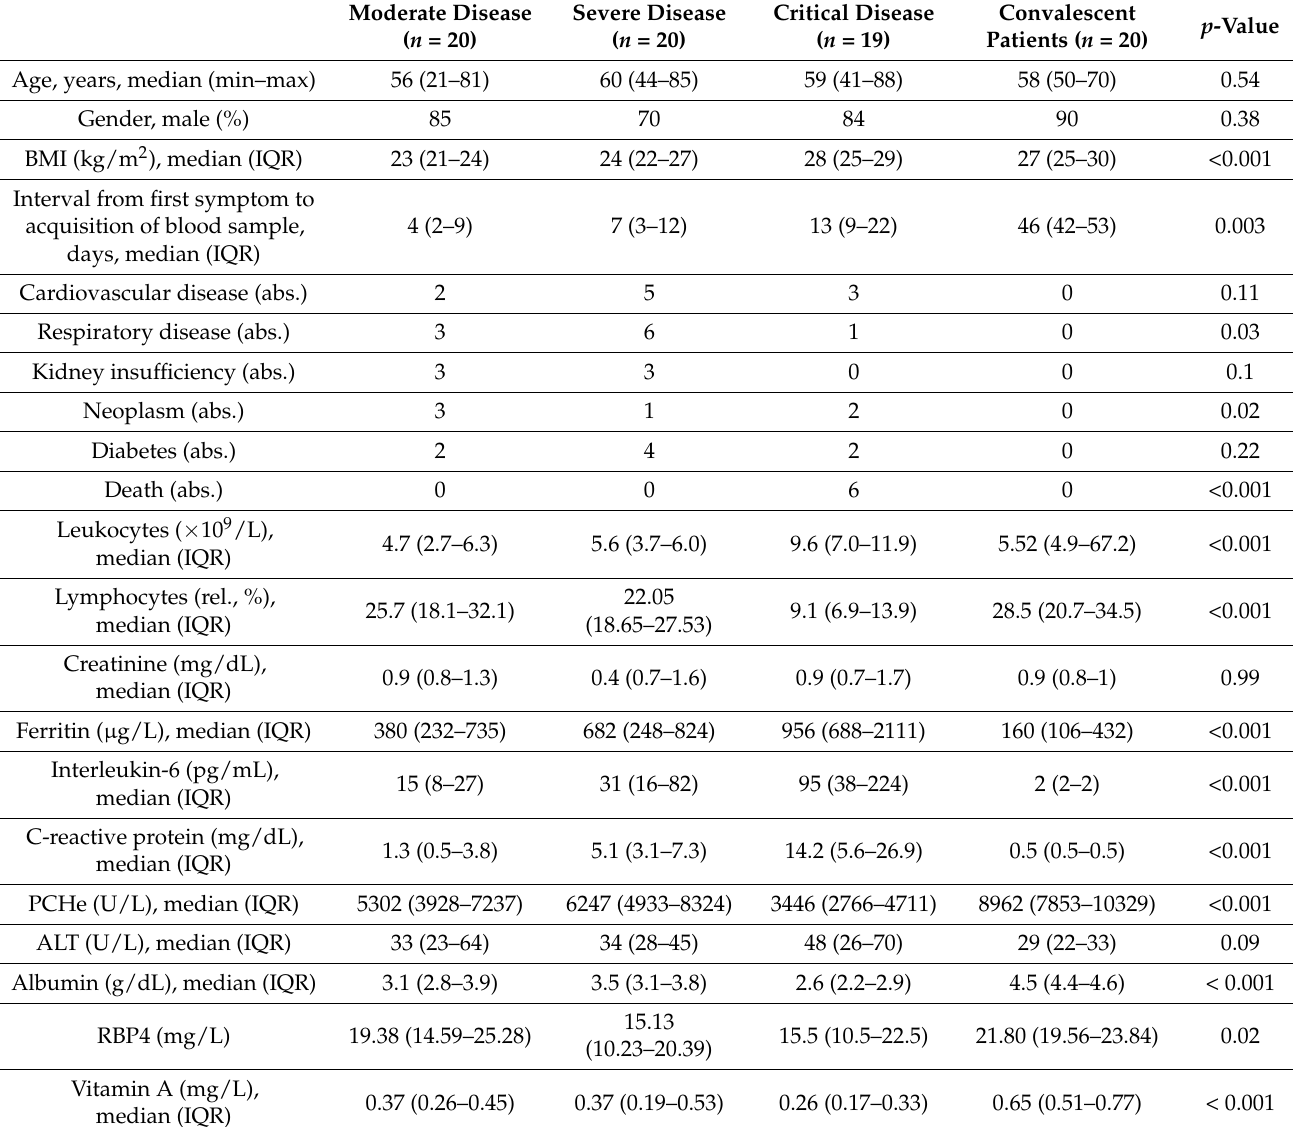
Table 1. Patients’ characteristics of hospitalized and convalescent COVID-19